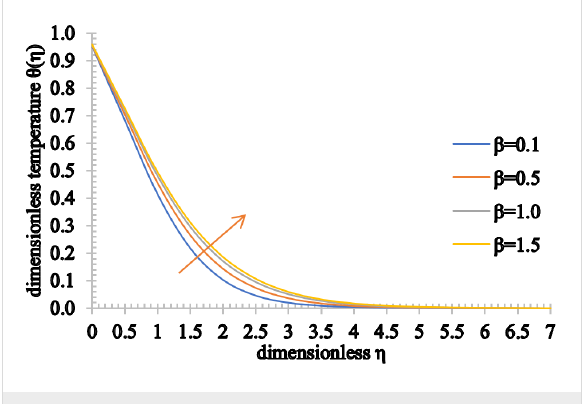
Figure 9: The temperature profile for increasing values of β .